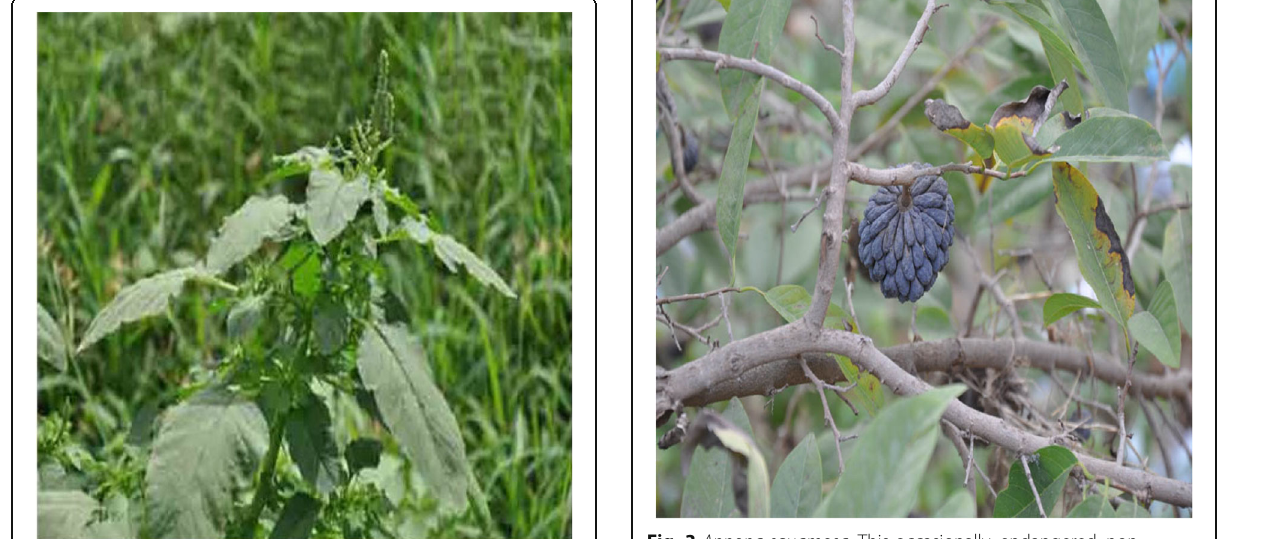
Fig. 3 Annona squamosa . This occasionally, endangered, non- endemic species belongs to the plant family Annonaceae (Copy source Jacob Thomas